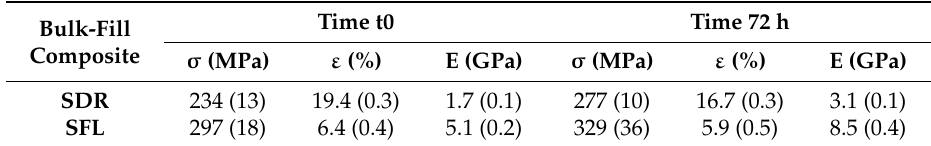
Figure 2. Shrinkage profiles recorded for SDR and SFL bulk-fill composites. Table 3. Mechanical properties measured in compression for the SDR and SFL bulk-fill composites. σ , ε , and E represent the compressive strength, the strain to failure, and the Young’s modulus, respectively. Numbers in brackets represent the standard